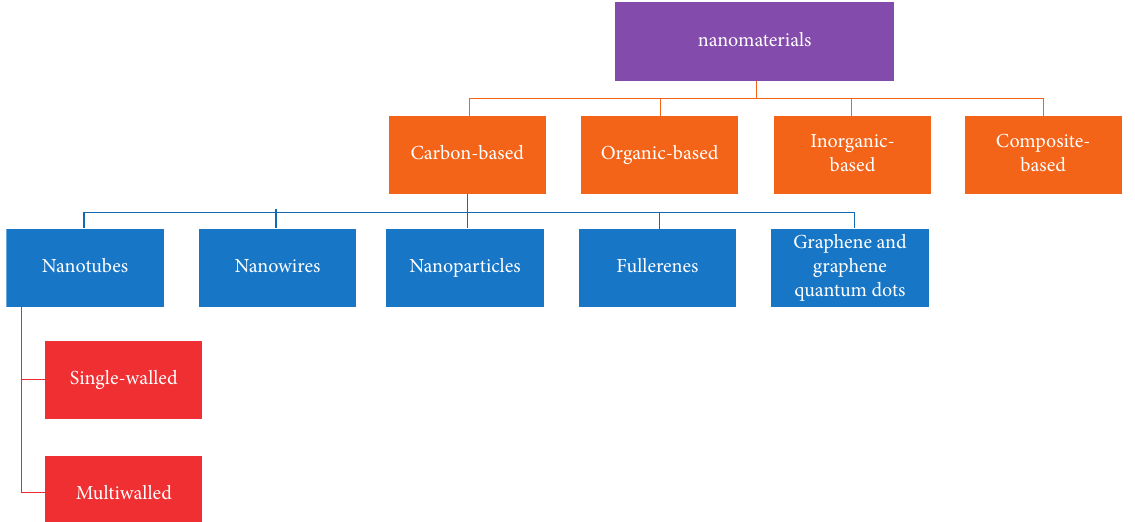
Figure 2: Different types of nanomaterial frequently used in